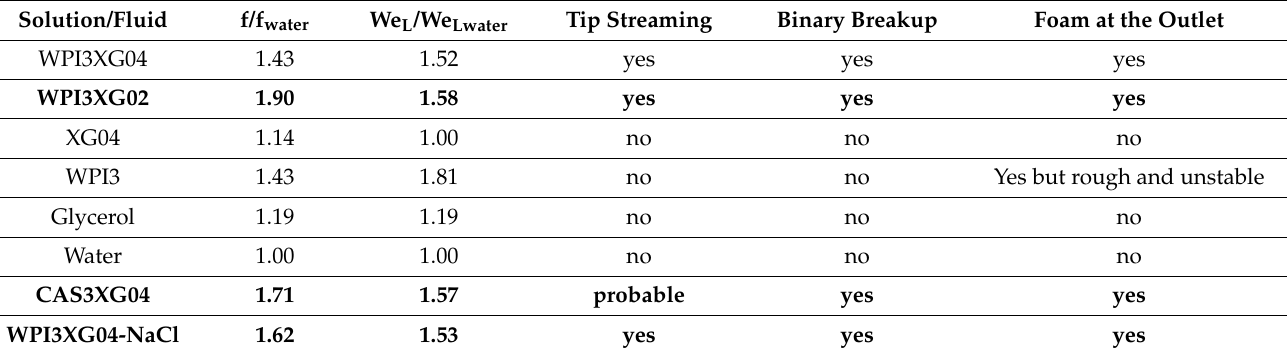
Table 9. Qualitative summary of the effect of the formulation on the two-phase flow in the mixing channel of the device CX600. The ratios concern the flow in the mixing channel; they are calculated at Q vL = 11 L · h − 1 − Q mG = 21.6 g · h − 1 . The liquid flowrate for CAS3XG04 was slightly lower (Q vL = 10.6 L · h − 1 − Q mG = 21.6 g · h − 1 ). The indications “yes” and “no” in the 4th and 5th columns refer to the visual presence or absence of bubble breakup mechanisms discussed in this study: i.e., tip-streaming in the mixing channel and binary breakup in the expansion channel of CX-E-600. The last column indicates if the solution/fluid allowed us to obtain a foam or